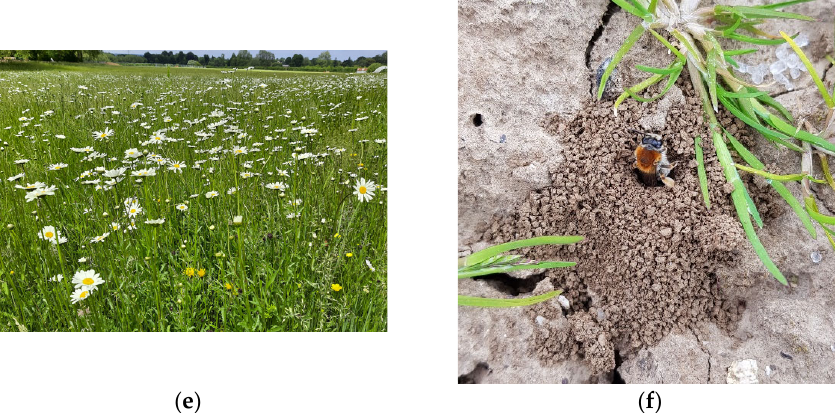
Figure 2. ( a ) Woolly apple aphid colony (credit NIAB EMR), ( b ) hoverfly on a strawberry flower (credit NIAB EMR), ( c ) apple scab ( Venturia inaequalis ) on damaged fruits (credit NIAB EMR), ( d ) diverse and abundant floral mix of different flower types (credit Celine Silva), ( e ) oxeye daisy ( Leucanthemum vulgare ) (credit Celine Silva), and( f ) solitary bee nest with exposed tumuli (excavated soil) above ground (credit Konstantinos Tsiolis).